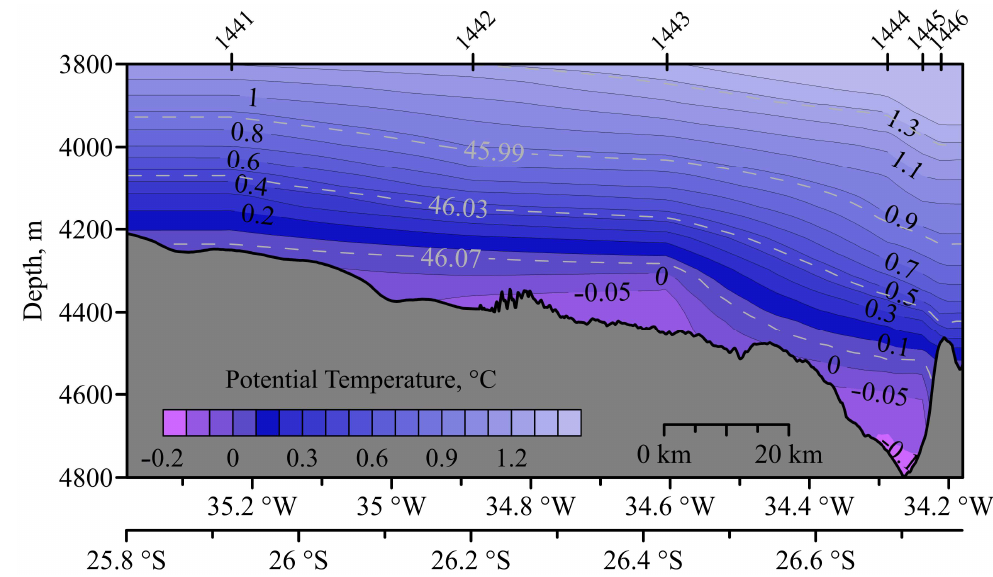
Figure 6. Potential temperature section north of the Vema Channel in 2003. Contour lines of density (~46 units) are shown.